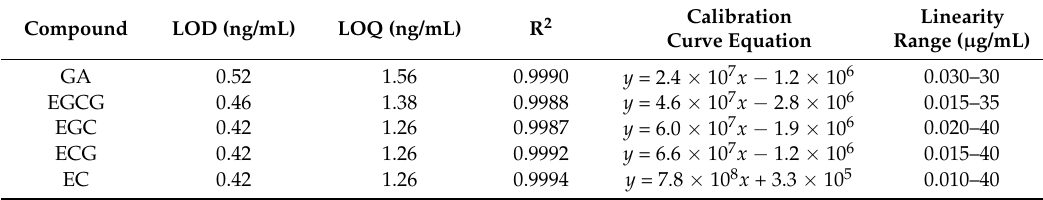
Table 4. Validation parameters obtained in the optimized LC-MS method ( n =